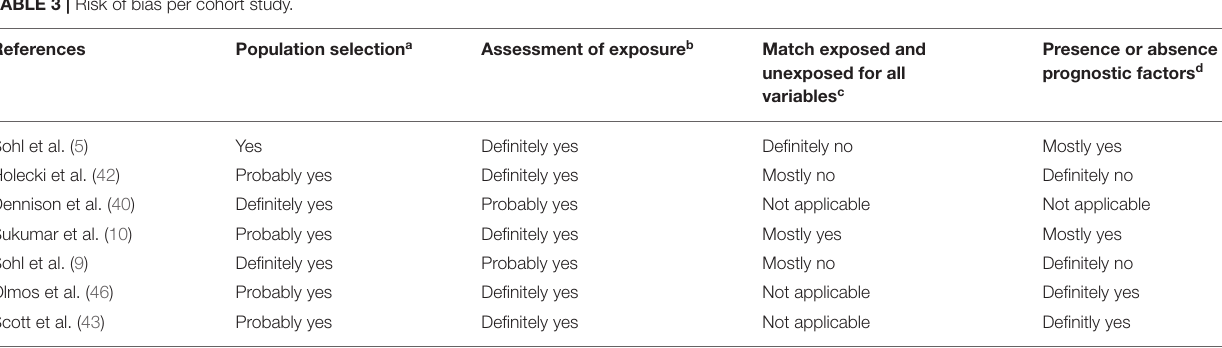
TABLE 3 | Risk of bias per cohort